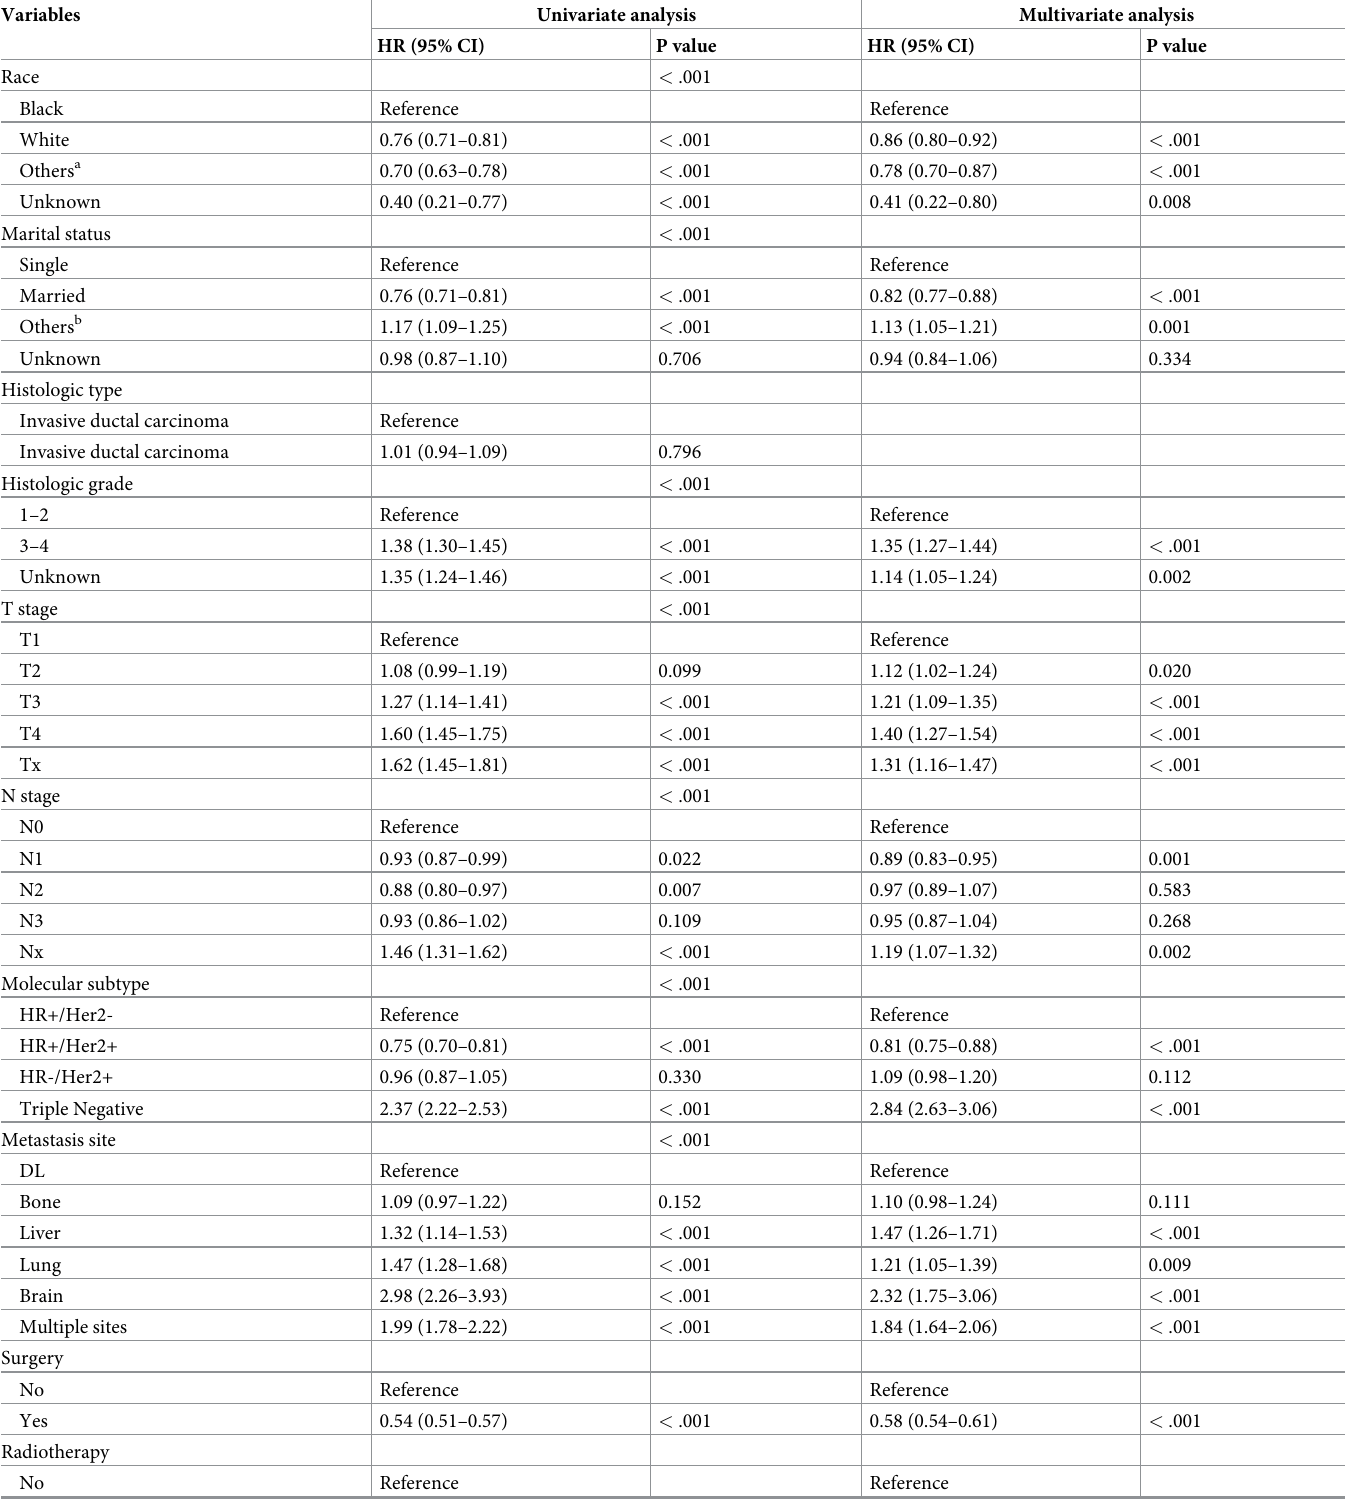
Table 3. Univariate analysis and multivariate analysis for overall survival (OS) among patients with metastatic breast